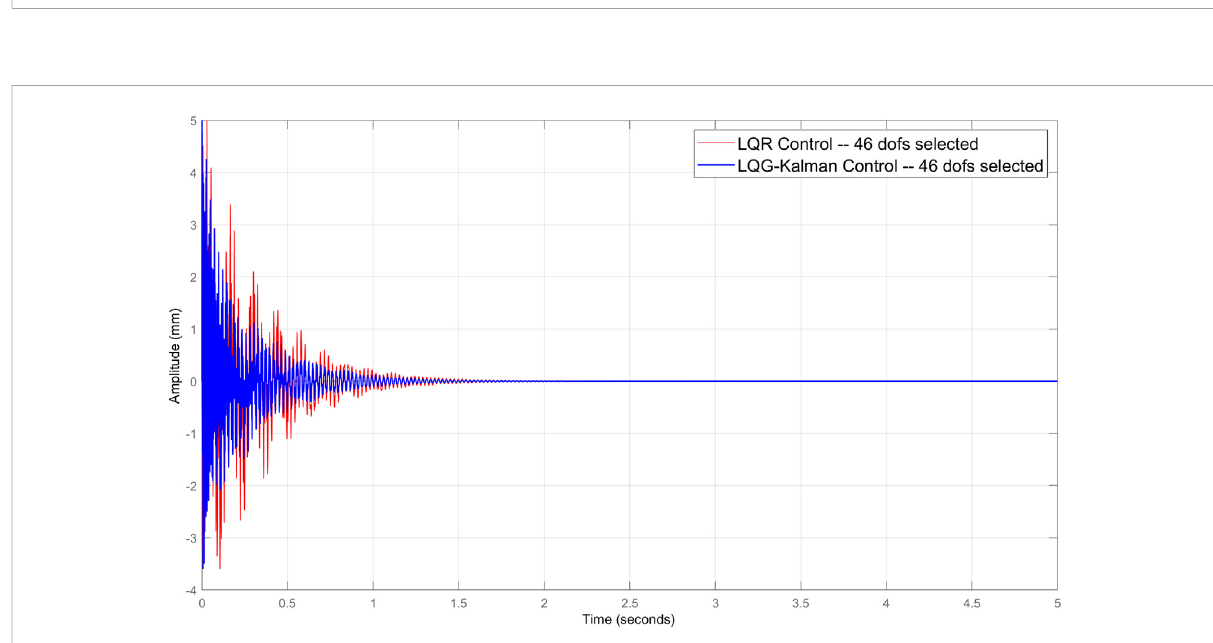
Comparison of LQR and LQG-Kalman controls considering only the selection of 46 degrees of freedom (the reduced model